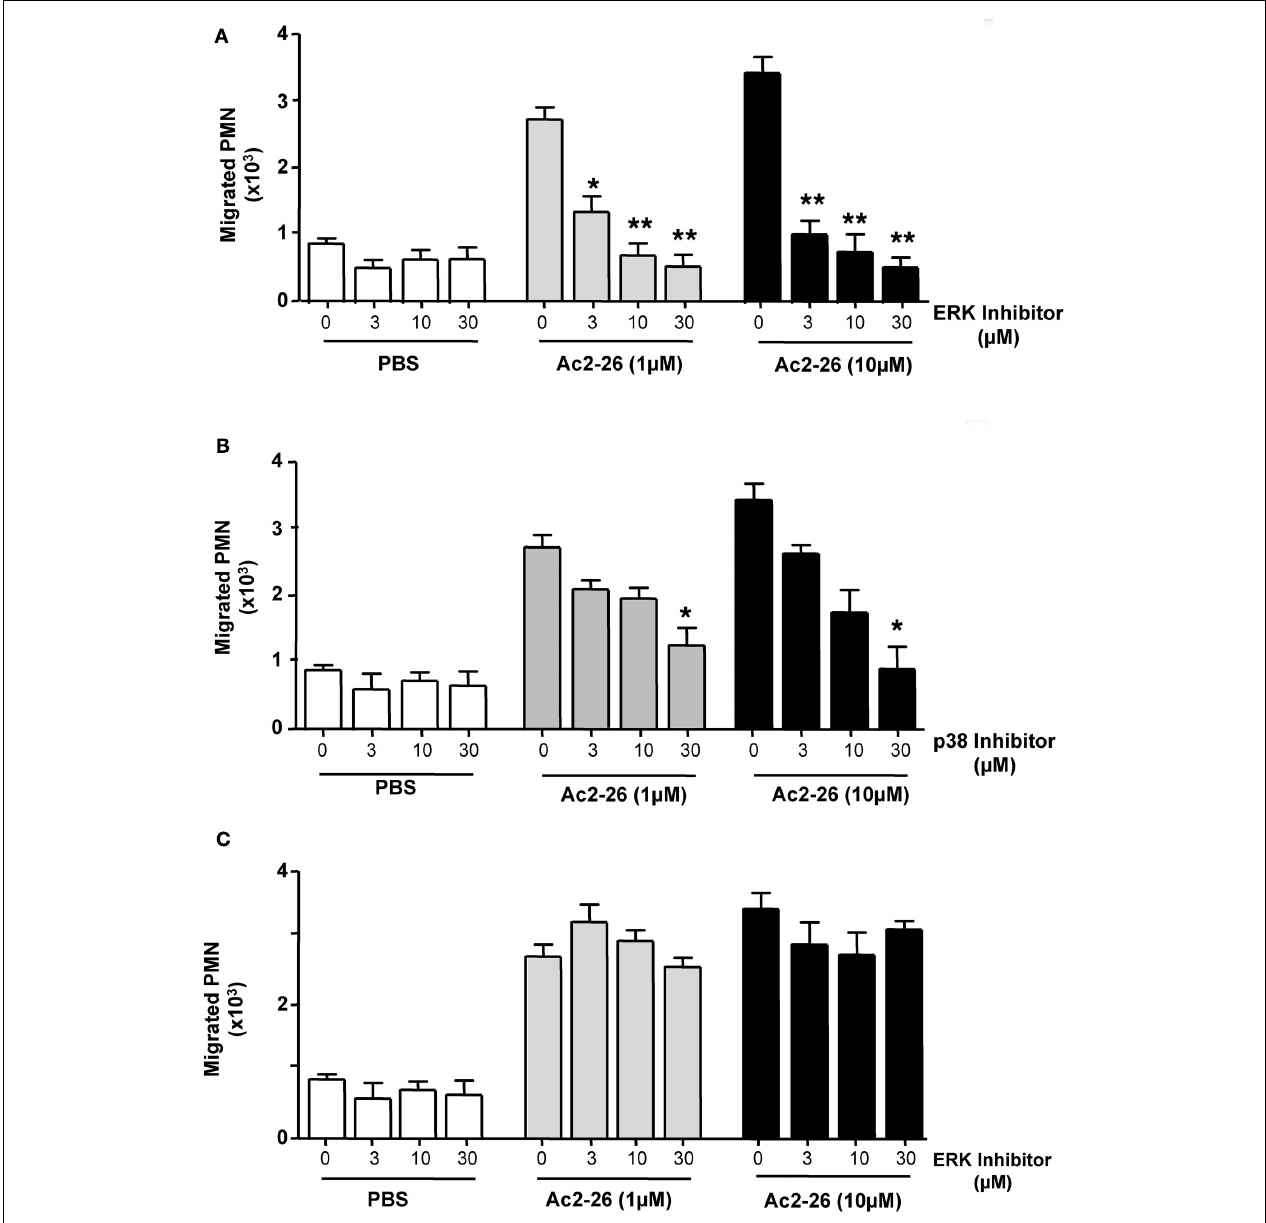
on to a 96 well ChemoTx™ plate in the presence of PBS or peptide Ac2-26 (3–30 μ M). Chemotaxis was evaluated after a 90-min incubation at 37˚C and 5% CO 2 . Results are ± SEM from three distinct cell preparations [* P < 0.05, ** P < 0.01 vs. stimulus alone (dose 0